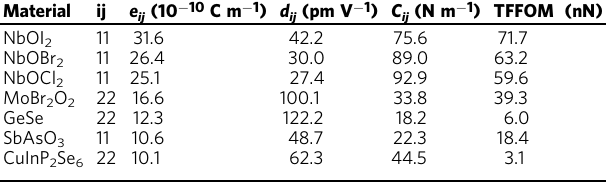
Table 1 Materials with e ij > 10 × 10 − 10 C m − 1 . Material